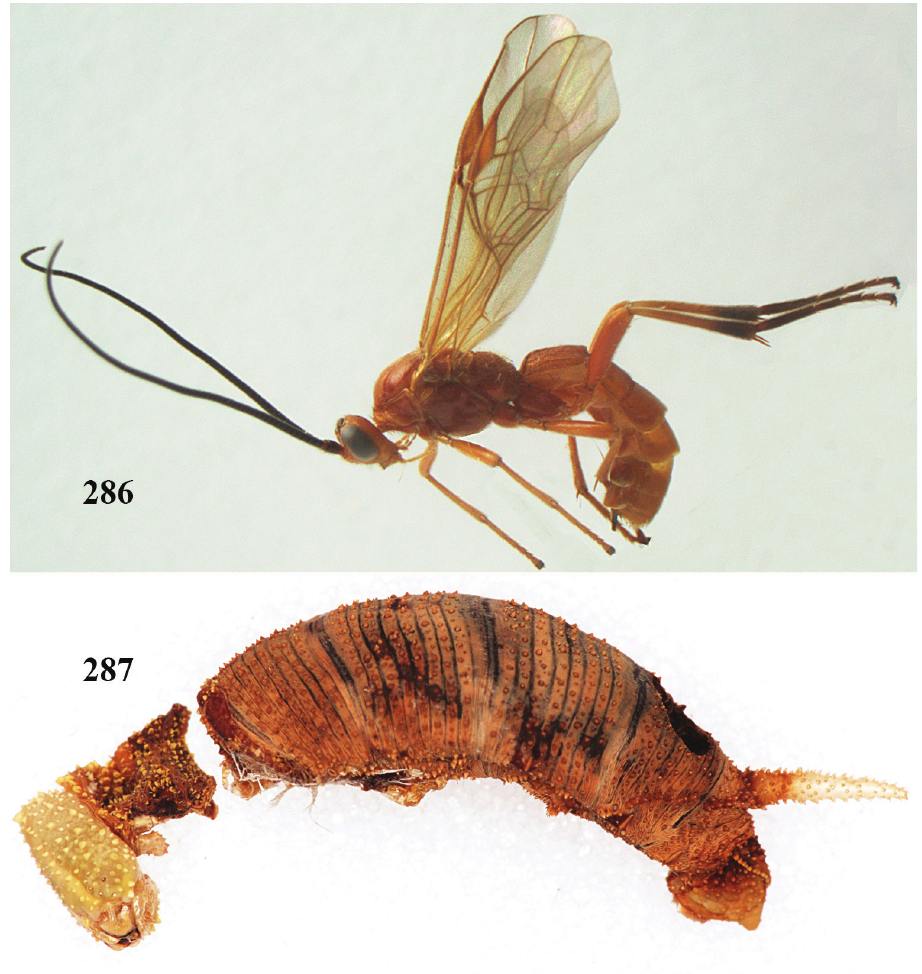
Figures 286–287. Aleiodes praetor (Reinhard), ♀ , Netherlands, Epen. 286 habitus lateral 287